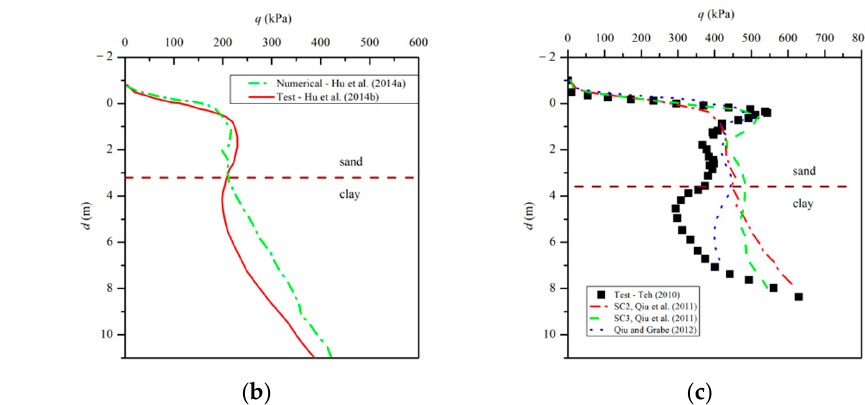
Figure 1. Comparison of simulated resistance profiles in dense sand overlying clay of the existing numerical models: ( a ) loose sand overlying clay [7,18,19]; ( b ) medium-loose sand overlying clay [11,12]; ( c ) dense sand overlying clay [9,20,24].